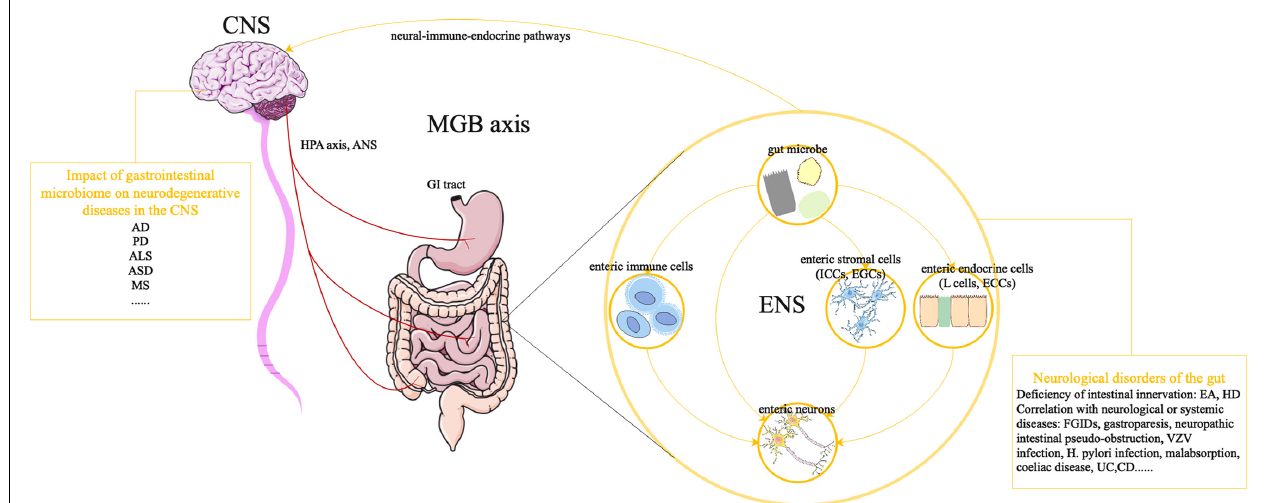
FIGURE 1 | Effects of GI microbiota on the ENS and MGB axis. The ANS, in combination with the HPA axis and neuroendocrine signaling, can induce CNS-modulated changes in the gut. Meanwhile, bacterial molecules and neural-immune-endocrine pathways impact the development of the CNS, giving rise to a dynamic communication network in the MGB axis. The development and function of the ENS are controlled by GI microbiota, through direct or indirect mechanisms. Bacterial molecules can pass through the intestinal epithelial barrier to directly interact with enteric plexuses or act on non-neuronal intermediary cells (e.g., enteric immune cells, ICCs, EGCs, EGCs, and enteric L cells), whose products can be detected by enteric neurons. Abnormalities in the ENS are associated with life-threatening GI disorders, which can be manifested as intestinal innervation deficiencies (e.g., EA, HSCR) and can be correlated with neurological or systemic diseases (gastroparesis and neuropathic intestinal pseudo-obstruction). In addition, gut microbes might be associated with neurodegenerative CNS diseases, such as AD, PD, ALS, ASD, MS, and other neurological diseases. CNS, central nervous system; ANS, autonomic nervous system; HPA axis, hypothalamic-pituitary-adrenal axis; MGB axis, microbiota-gut-brain axis; AD, Alzheimer’s disease; PD, Parkinson’s disease, ALS, amyotrophic lateral sclerosis; ASD, autism spectrum disorder; MS, multiple sclerosis; GI, gastrointestinal; ENS, enteric nervous system; ICCs, interstitial cells of Cajal; EGCs, enteric glial cells; ECCs, enterochromaffin cells; EA, esophageal achalasia; HSCR, Hirschsprung disease; FGIDs, functional gastrointestinal disorders; VZV, varicella-zoster virus; H. pylori , Helicobacter pylori ; UC, ulcerative colitis; CD, Crohn’s